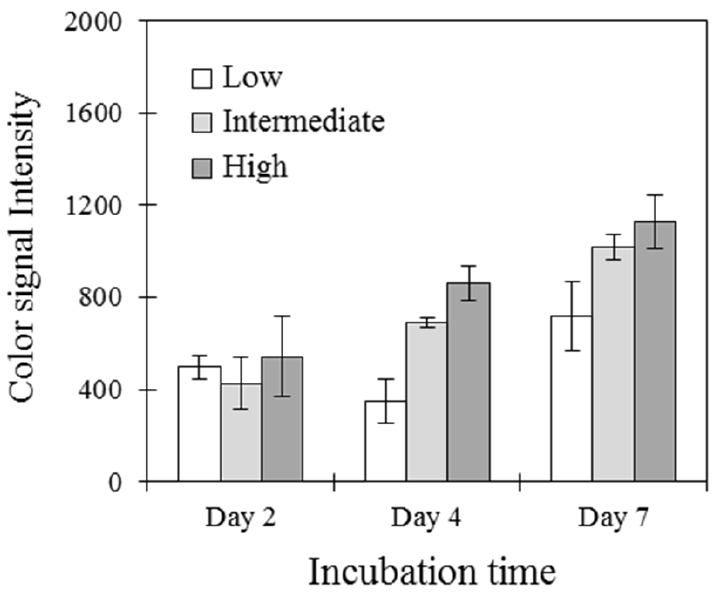
Figure 6. Comparison of TLR1 expression levels with different cell densities. Cells at low, interme- diate, and high concentrations were provided to the membrane filter-assisted biosensing cartridge. The color signals were detected for TLR1 levels overexpressed from the bacterial lysate at different incubation times of 2, 4, and 7 days from the initial culture.